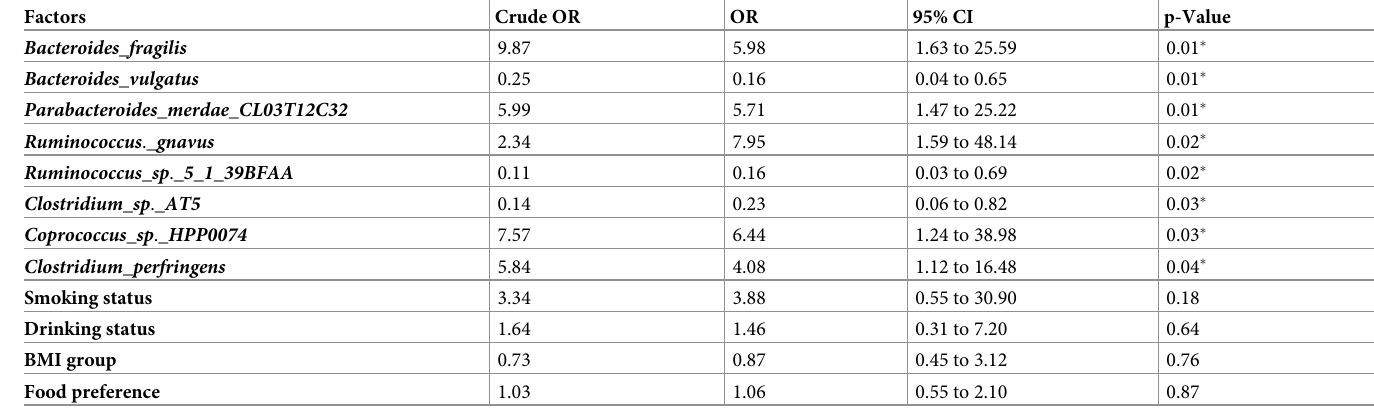
Table 3. Relationship between bacterial taxa and longevity adjusted for smoking, alcohol consumption, body mass index (BMI) and food